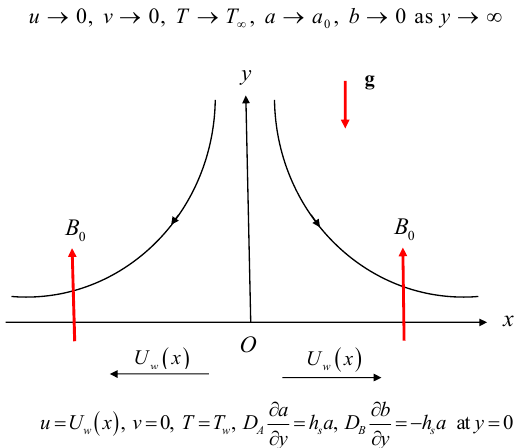
Figure 1. Flow configuration and boundary conditions. Table 1. Physical properties of water and Cu